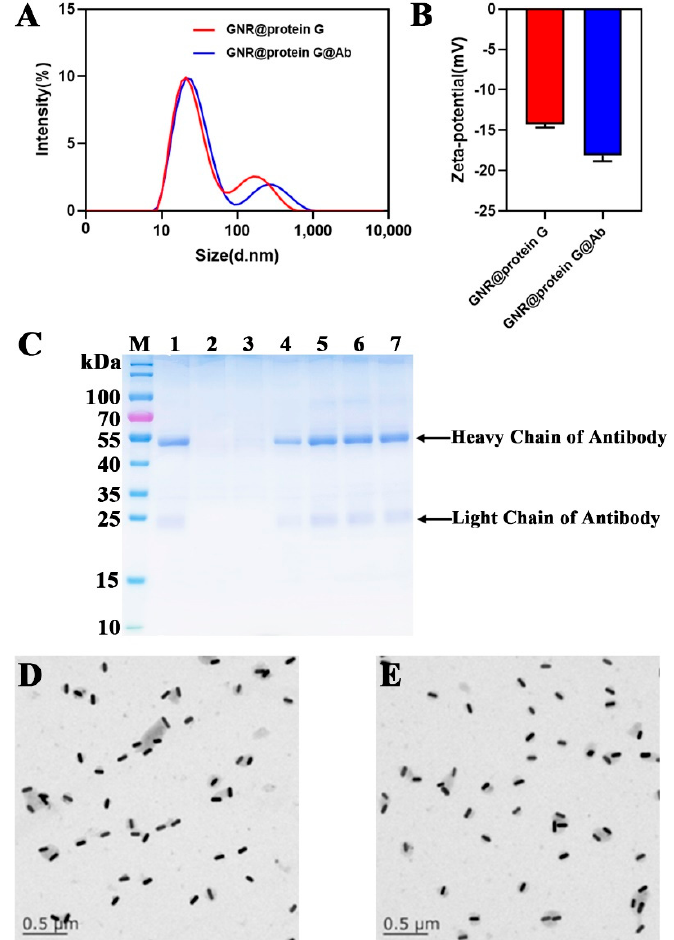
Figure 4. Characterization of GNR probes. ( A ) Hydrodynamic sizes of GNR@protein G and GNR@protein G@Ab. ( B ) Zeta potentials of GNR@protein G and GNR@protein G@Ab. ( C ) SDS-